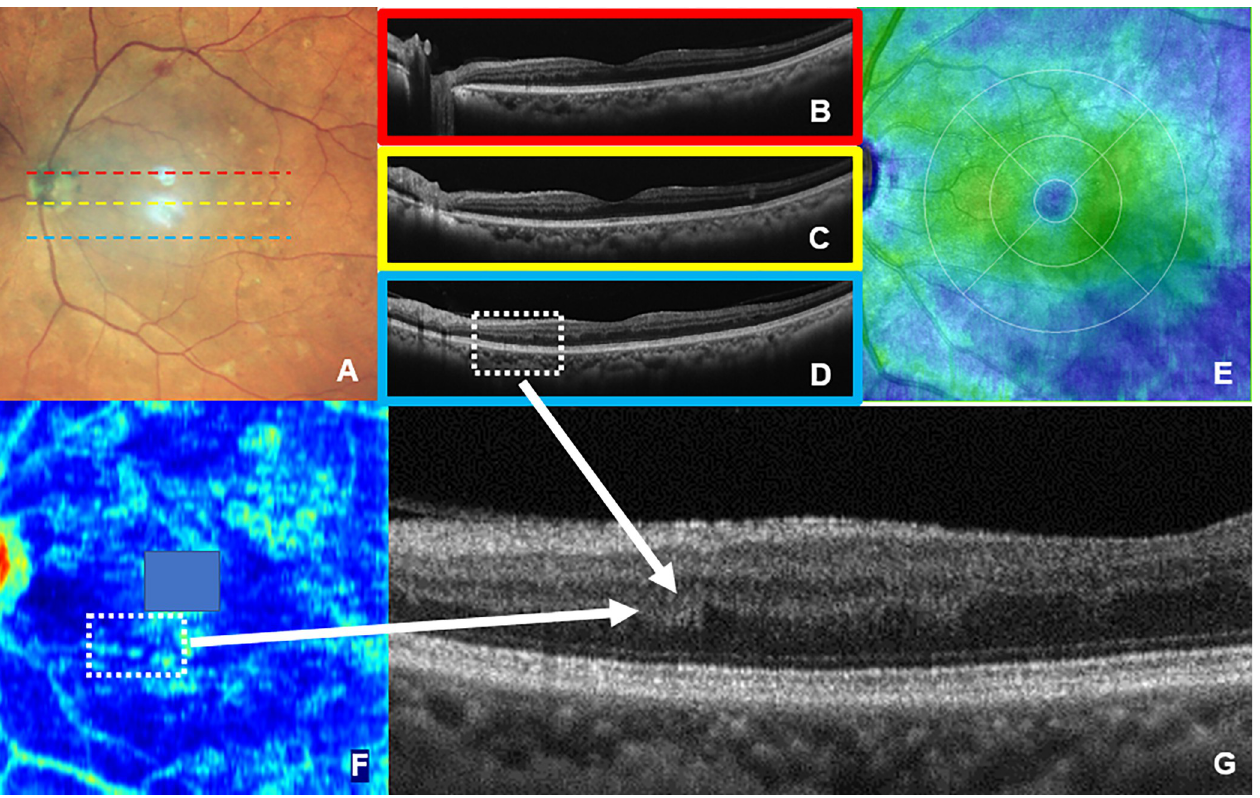
Fig 8. Ocular findings of case 2. Color fundus photography (A). OCT image of A-scan with dotted red, yellow, and blue lines (B, C, and D). The color map (E) reflects the thickness of the retina in the same case. These findings are consistent with those of simple diabetic retinopathy. However, when the heatmap (F) based on Amb-I shows an image of the OPL/ONL boundary layer, a light-blue island with a large Amb-I is observed in the layer below the macula. Therefore, if that part is magnified (dotted line qualification part of D and F), the presence of a distortion in the OPL/ONL (G) can be observed. From this, it can be determined that distortion begins at the layer structure of the retina, despite simple